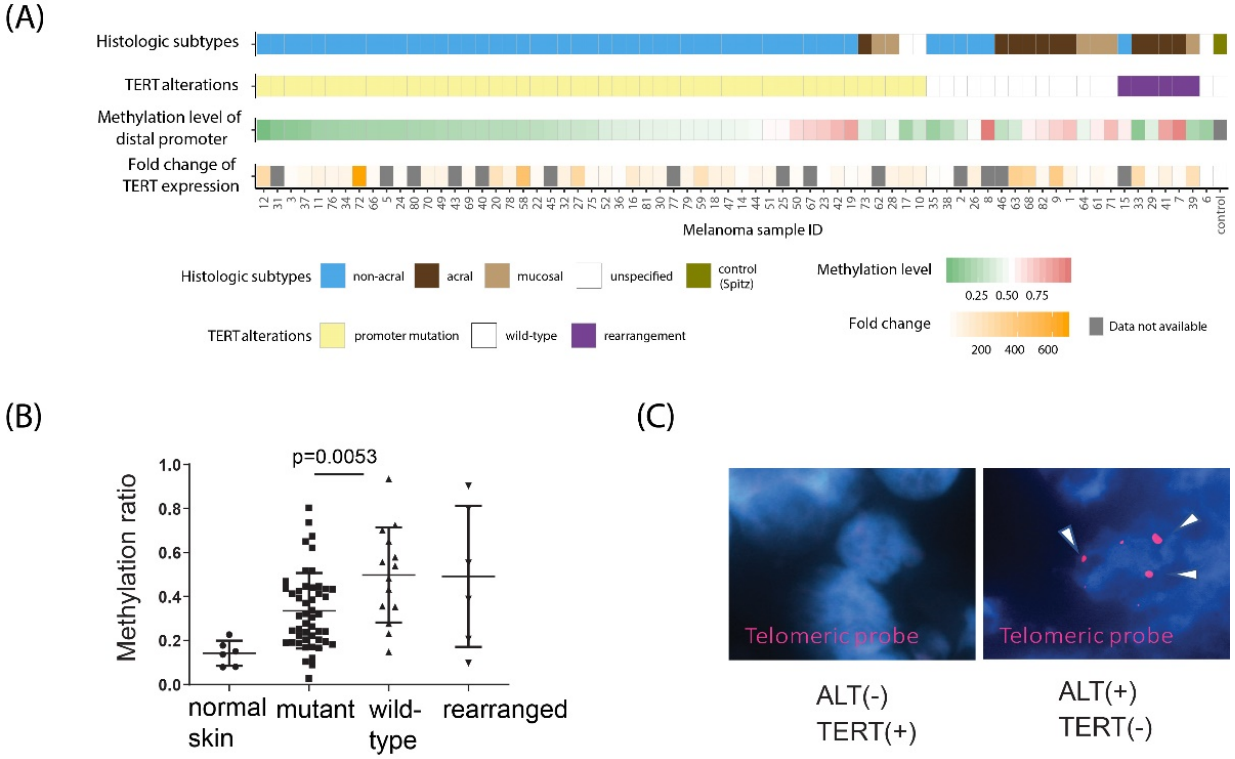
Figure 1. TERT promoter mutations, rearrangements, and promoter methylation are common in TERT–expressing adult metastatic melanomas . ( A ) TERT promoter mutations, rearrangements, and promoter methylation levels in adult metastatic melanomas were assessed by Sanger sequencing, FISH, and high–throughput bisulfite sequencing, respectively. Histological subtypes of melanomas were determined by morphologic criteria in the primary tumors. TERT mRNA expression levels were measured by RT–qPCR and normalized to both control Spitz sample and GAPDH mRNA levels. Normal skin samples were used as negative controls for TERT expression. ( B ) Average methylation of the TERT distal promoter CpGs (chr5:1,295,586–1,295,771) in normal skin and in mutant, wild– type, and TERT –rearranged melanomas. ( C ) Telomere FISH signal collected with a Cy3–labeled telomere probe revealed that a TERT alteration–negative melanoma (sample #6) had exceptionally high telomere content (arrows; right panel), which is indicative of ALT mechanism activation. In comparison, a TERT –positive melanoma (left panel) did not exhibit a strong telomere FISH signal, consistent with no